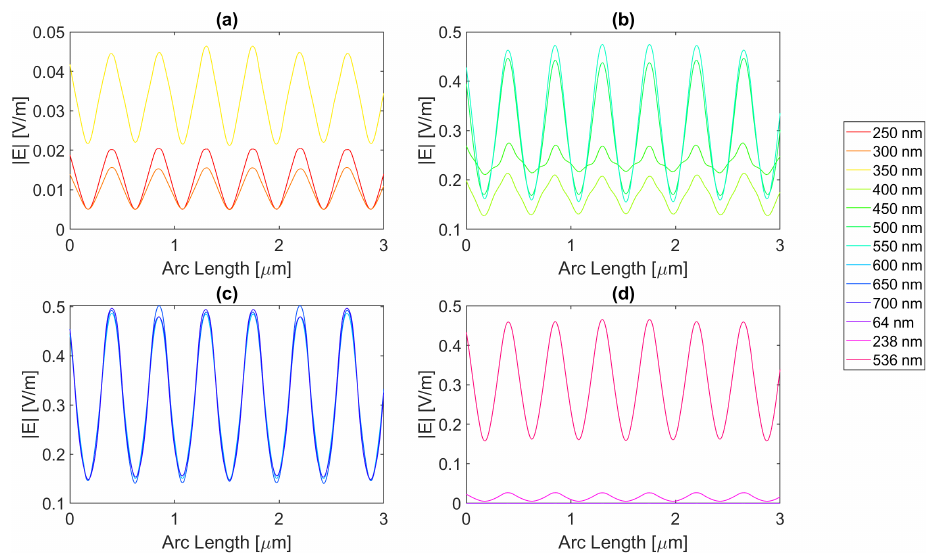
Figure 26. Electric field for the gold triangular nanostructure with a 200 nm base—Probe 1.